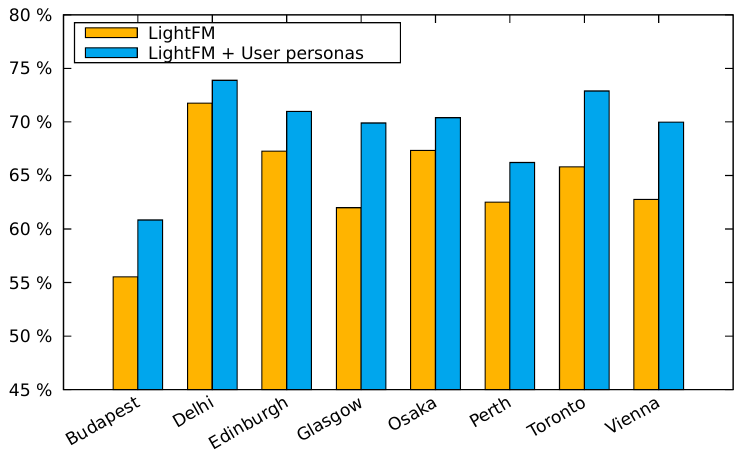
Figure 6. Mean Reciprocal Rank